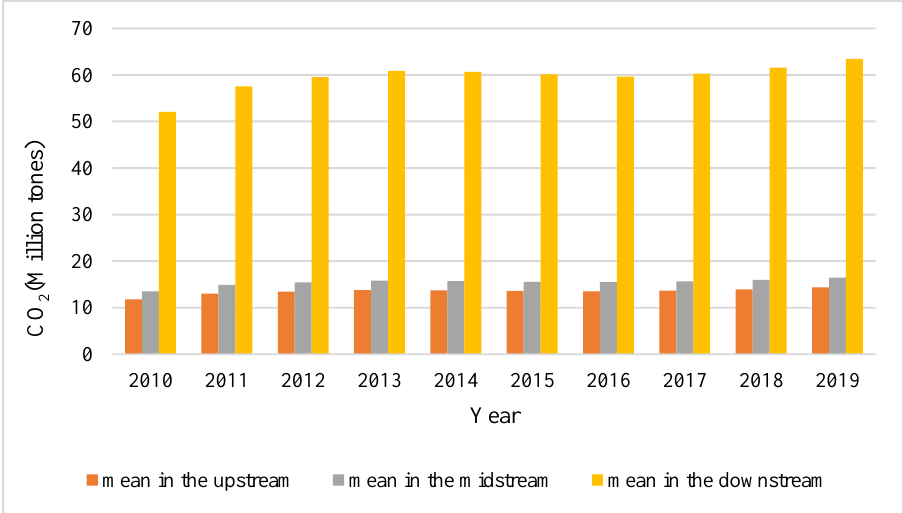
Figure 2. CO 2 emissions mean in the main stream of Yangtze River (2010 – 2019).